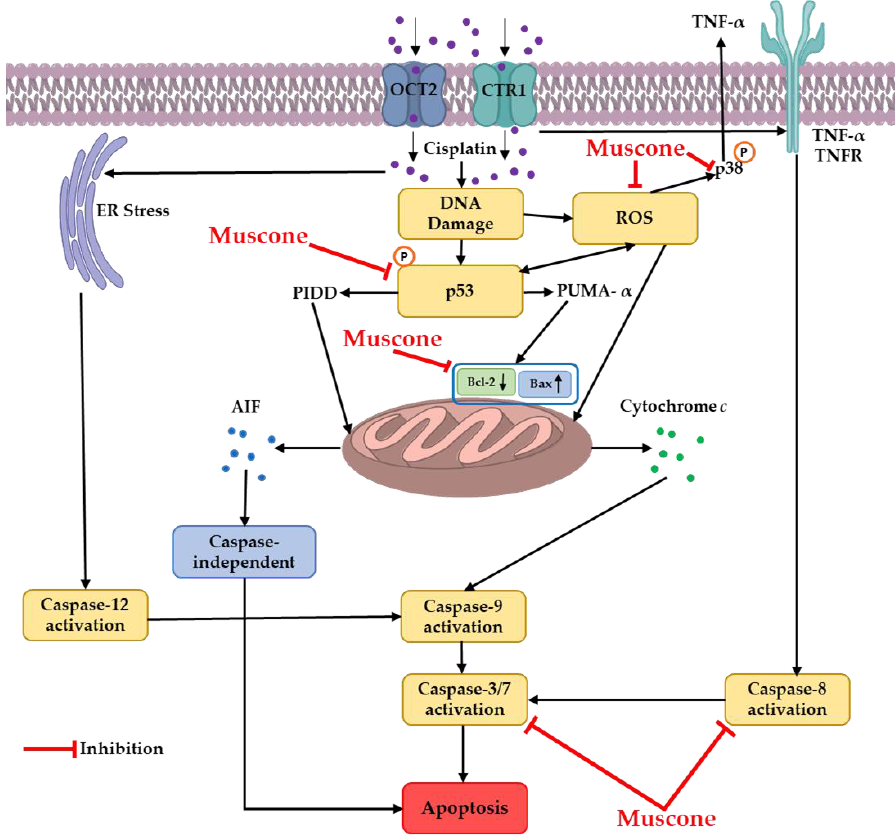
Figure 8. Cytoprotective mechanism of muscone against cisplatin nephrotoxicity in kidney proximal tubule LLC-PK1 cells.